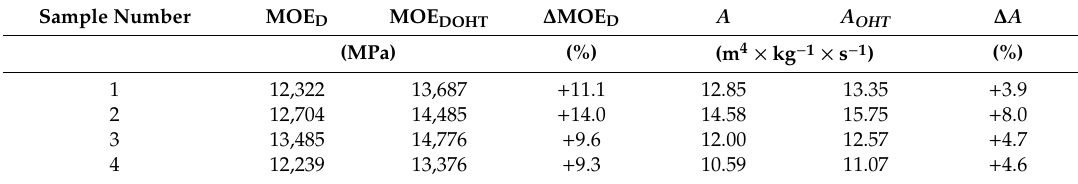
Table 5. Mean values of spruce-wood dynamic MOE, before and after modifications.